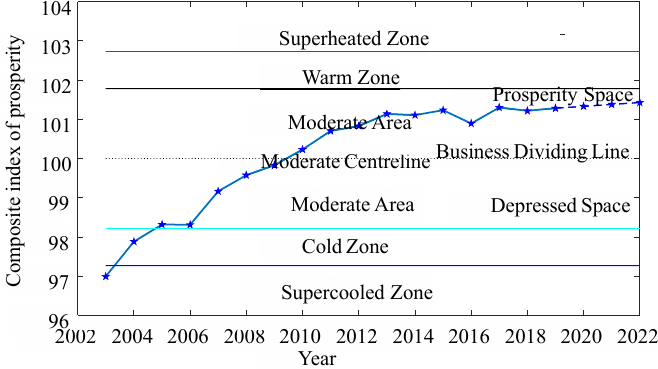
Figure 9. Direct forecast results